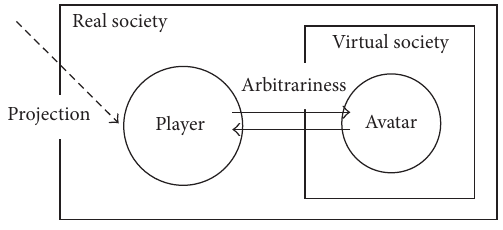
Figure 1: The dual structure of societies.